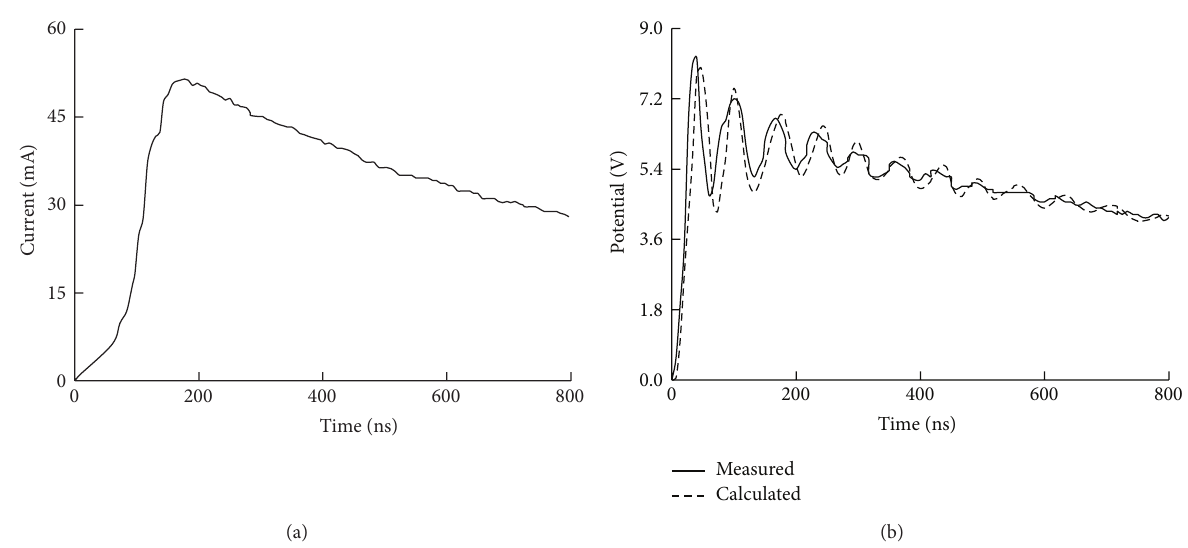
Figure 11: Comparison between measured and calculated waveforms. (a) Injected current. (b) Transient potentials at tower top.